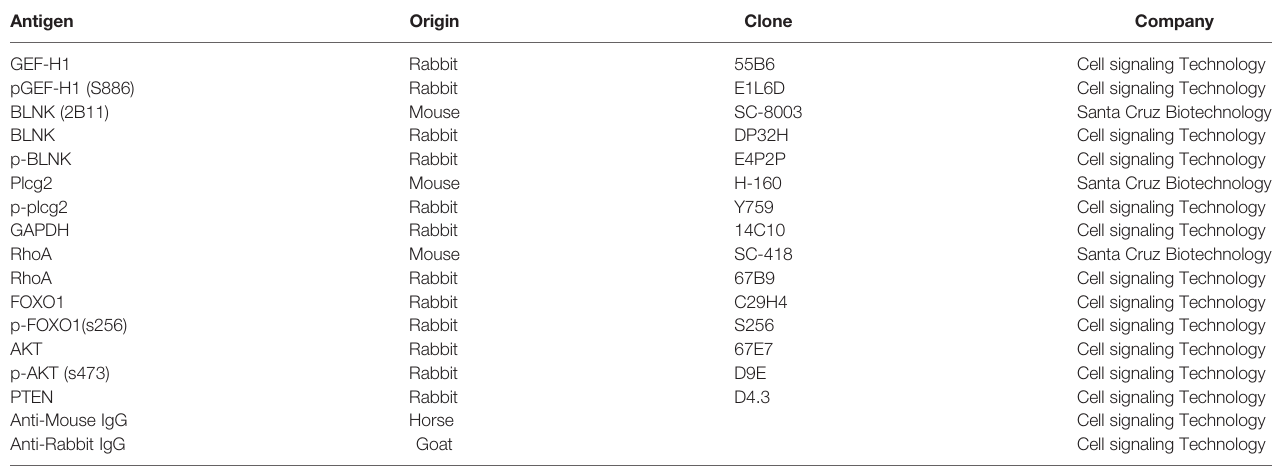
TABLE 2 | Antibodies used for Immunoblotting. Antigen